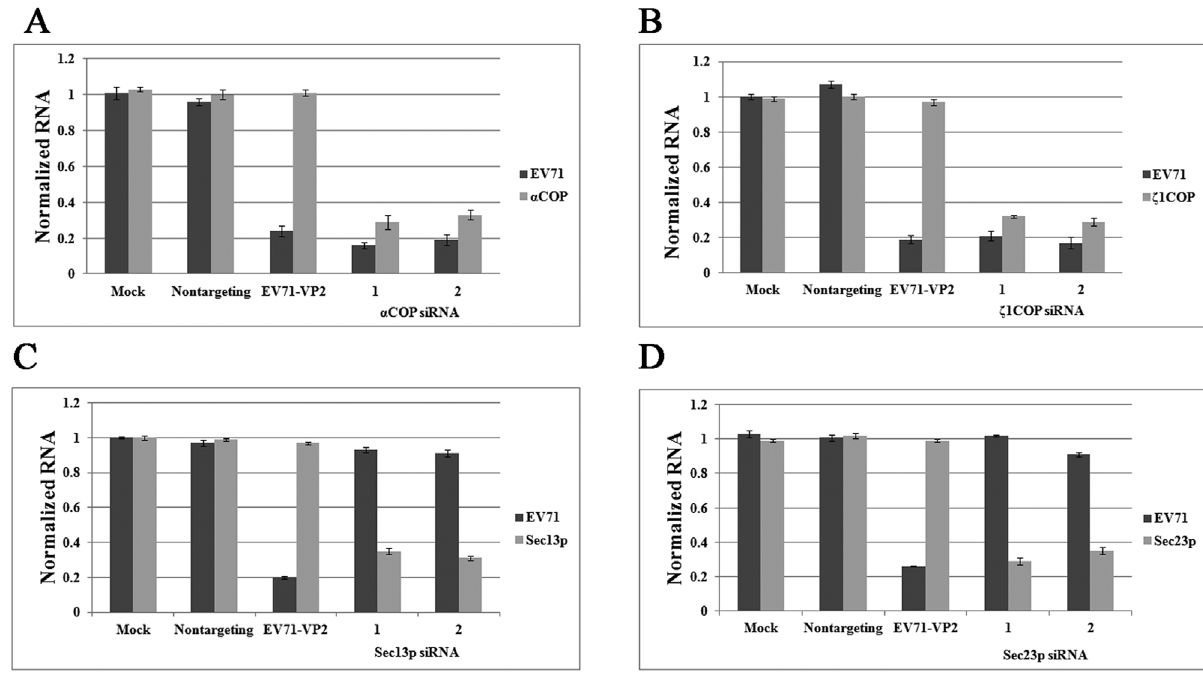
Figure 1. COPI but not COPII is essential for EV71 replication. COPI subunits (A) a COP and (B) f 1COP silencing with two individual siRNA duplexes blocked replication of EV71 ( P , 0.05). COPII subunits (C) Sec13p and (D) Sec23p depletion by siRNA was dispensable to EV71 replication ( P . 0.05). Values were obtained from triplicate wells and are mean 6 SD.